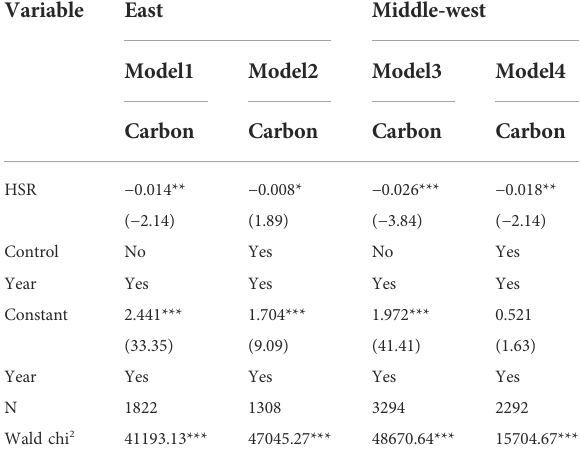
TABLE 6 The moderating effect of the reform of administrative examination and approval.